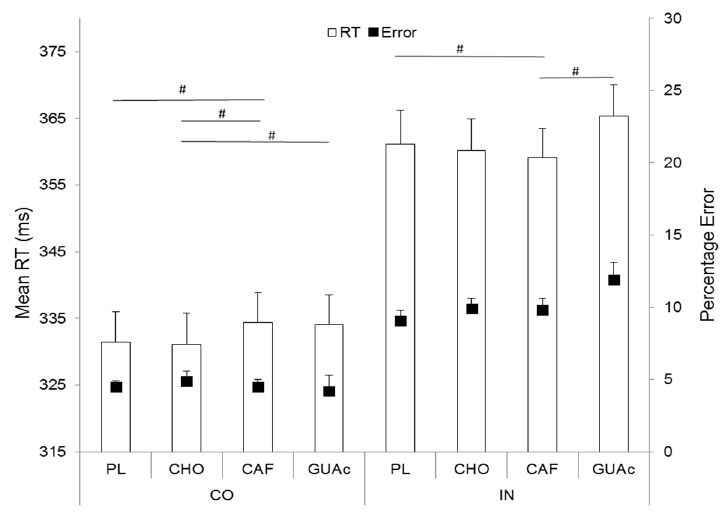
Figure 3. Mean reaction time (RT) and errors as a function of supplementation and congruency. Errors bars represent standard errors of mean RT. # 75–95% likely different.